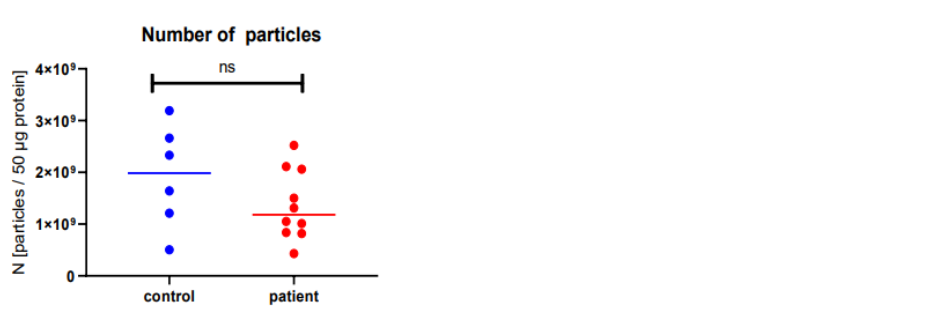
Figure A2. Metabolic profiles of controls and breast cancer patients show no difference in ( a ) the heatmap cluster or ( b ) principal component analysis.